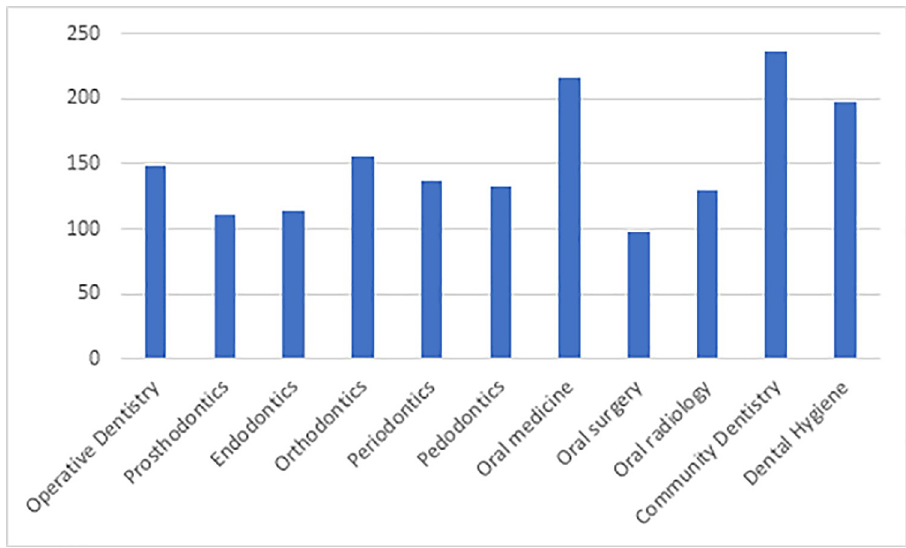
Fig 2. Preferred dental specialty for application of